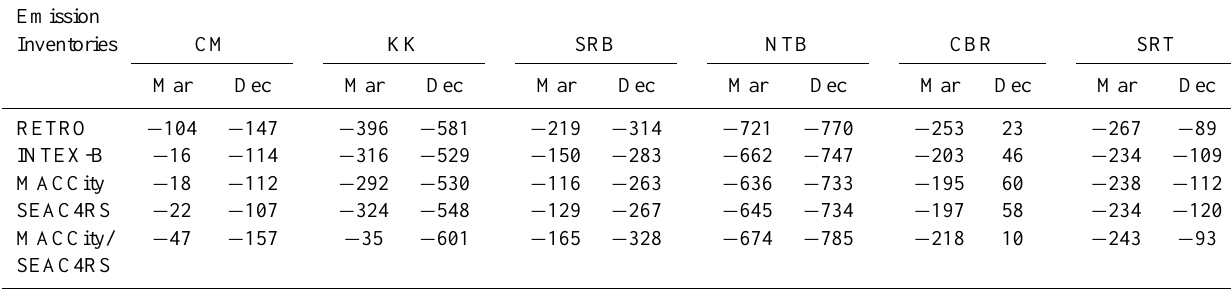
Table 4. Monthly-average biases of daytime (00:00, 06:00, 12:00UTC) carbon monoxide.